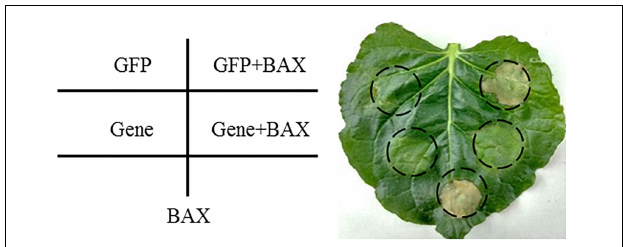
FIGURE 4 | Transient expression of candidate secreted effector proteins (CSEPs) in N. benthamiana suppressed programmed cell death triggered by BAX schematic. N. benthamiana leaves were infiltrated with A. tumefaciens cells containing PVX vector carrying enhanced green fluorescent protein (eGFP) (negative control) or CSEPs, respectively, followed by inoculating with A. tumefaciens cells carrying PVX:BAX after 24 h. Photos were taken 5 days after